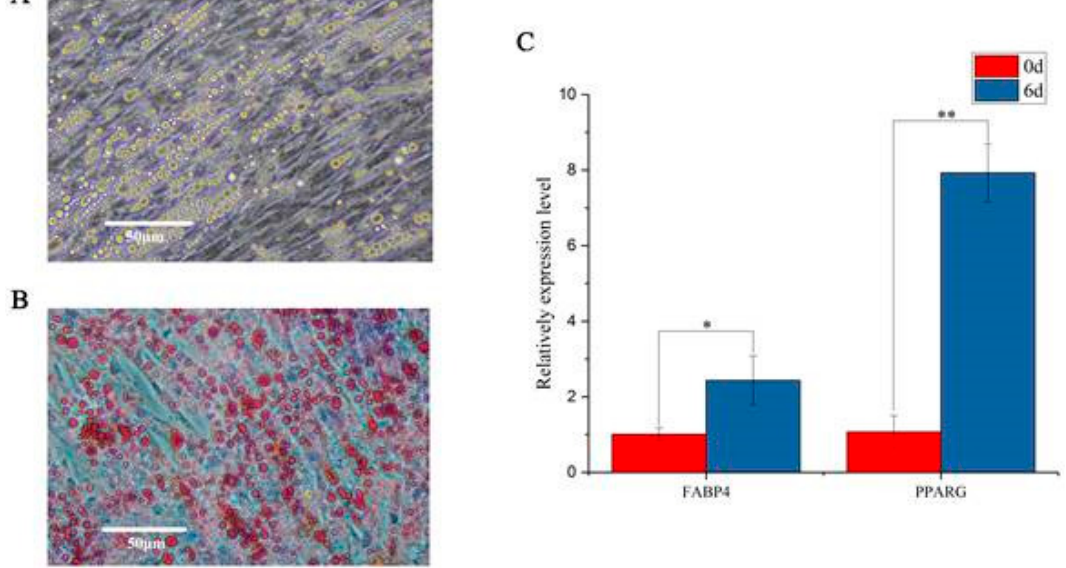
Figure 1. Di ff erentiation of chicken preadipocytes. ( A ) Di ff erentiated preadipocytes before oil red o staining. ( B ) Di ff erentiated preadipocytes stained using Oil red O. ( C ) The relative expression level of adipocyte marker genes before and after di ff erentiation. The relative expression level of FABP4 and PPARG genes significantly increased post-di ff erentiation, indicating that the chicken preadipocytes were successfully induced. *denotes p < 0.05, **denotes p < 0.01.